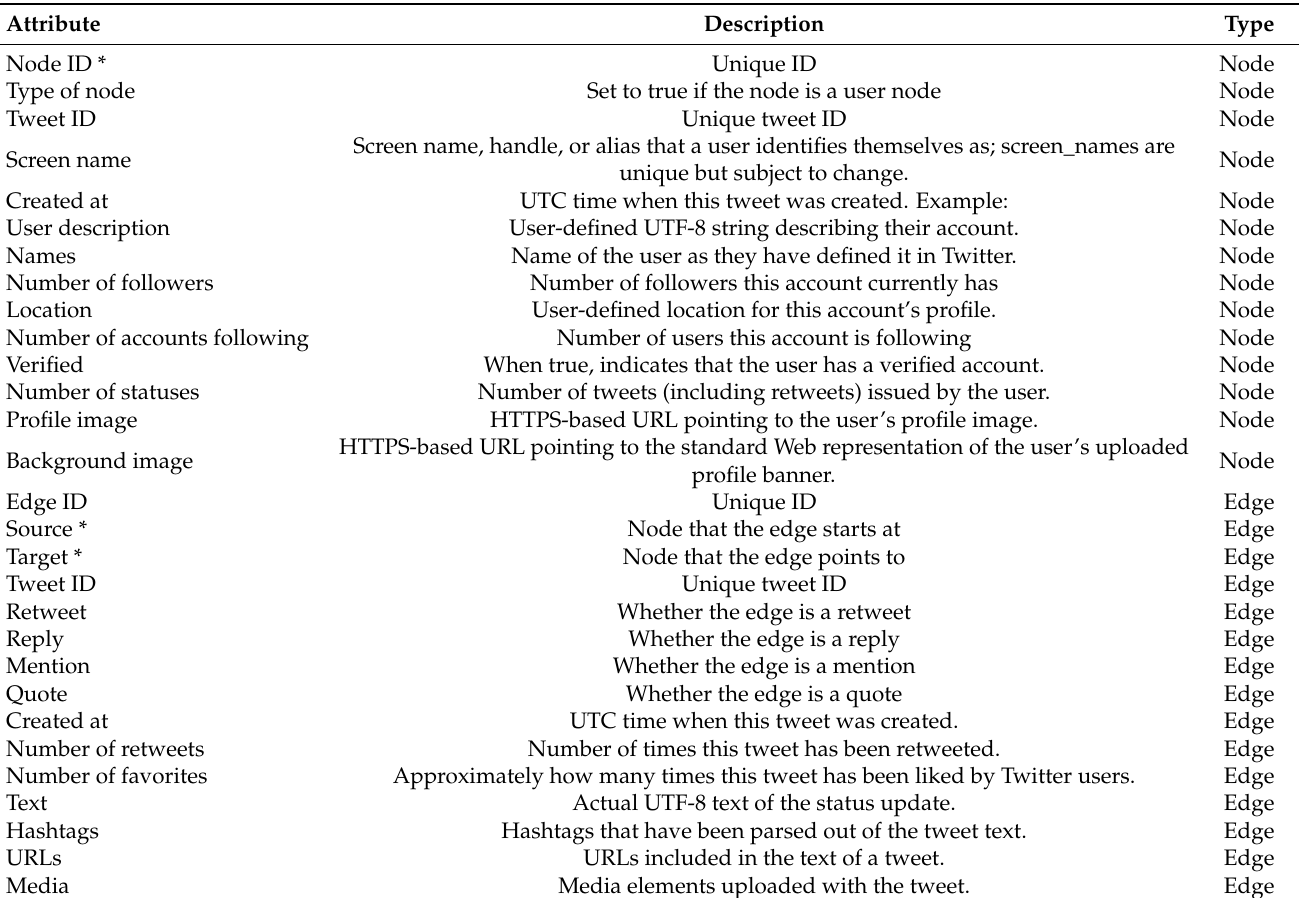
Table 1. Twitter’s attributes for building the graph and features. All fields marked with an asterisk (*) are